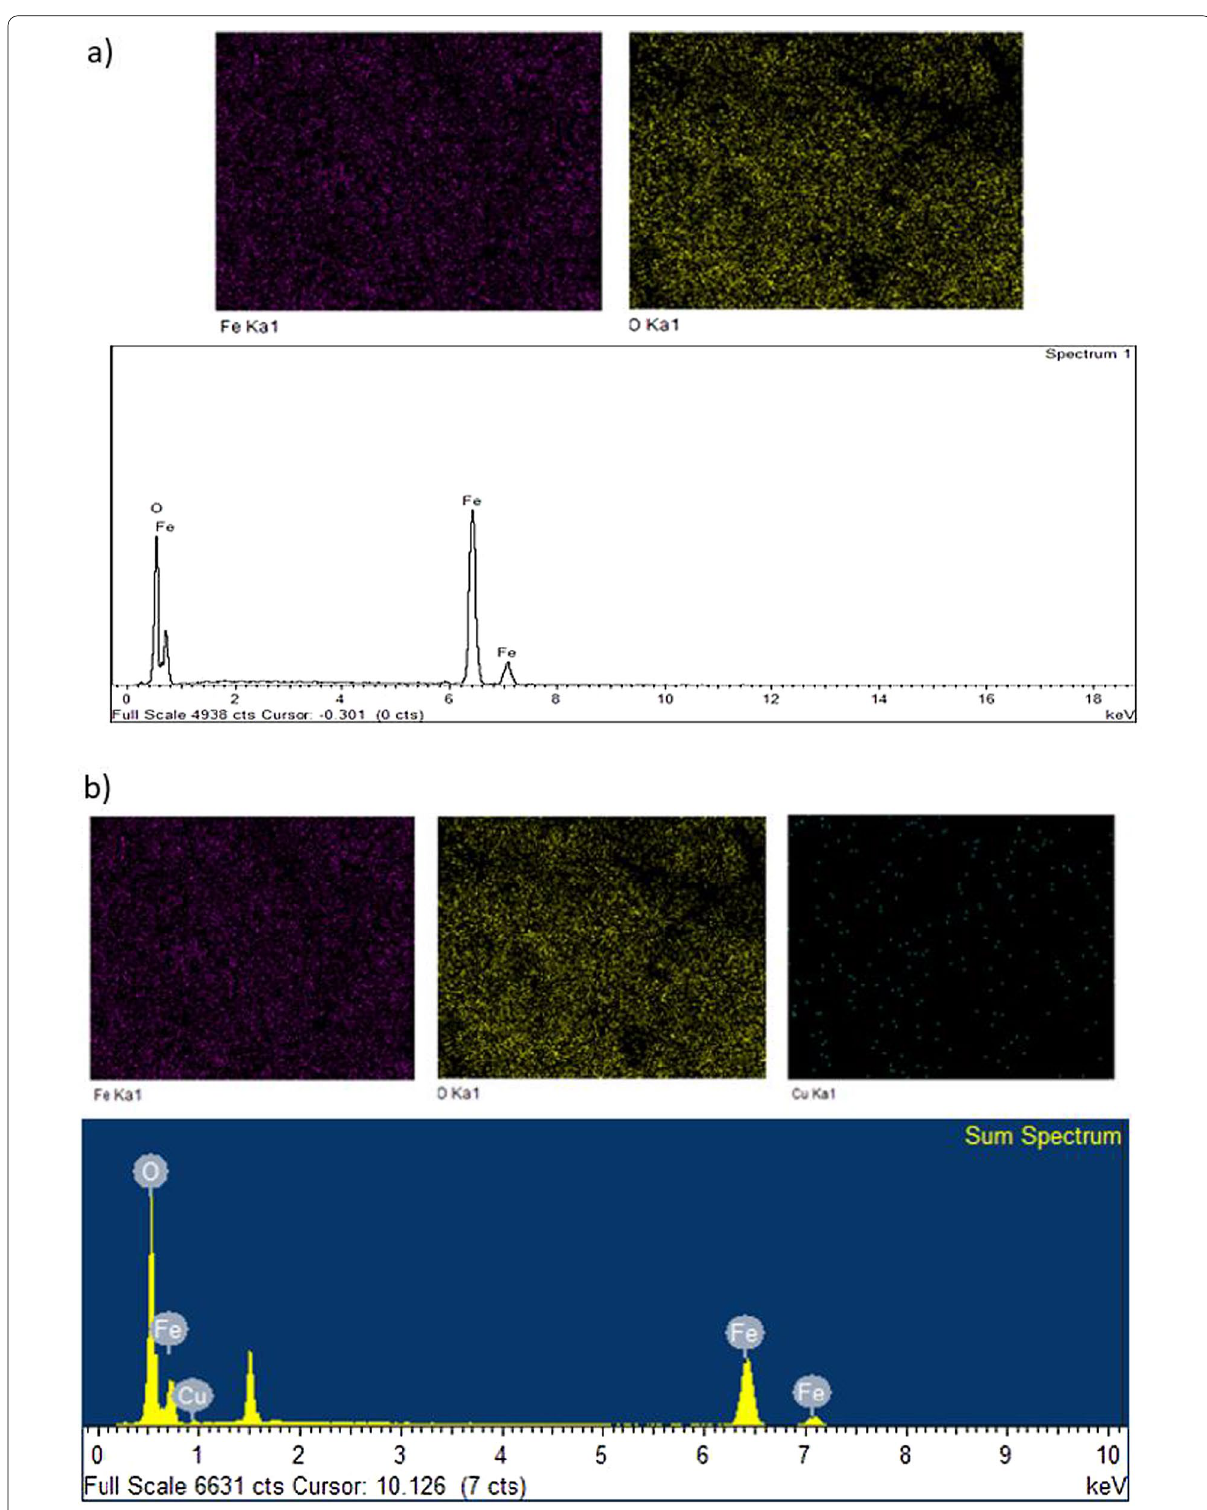
Fig. 7 EDS spectrum analysis ( a ) before the adsorption and ( b ) after adsorption of Cu (II)